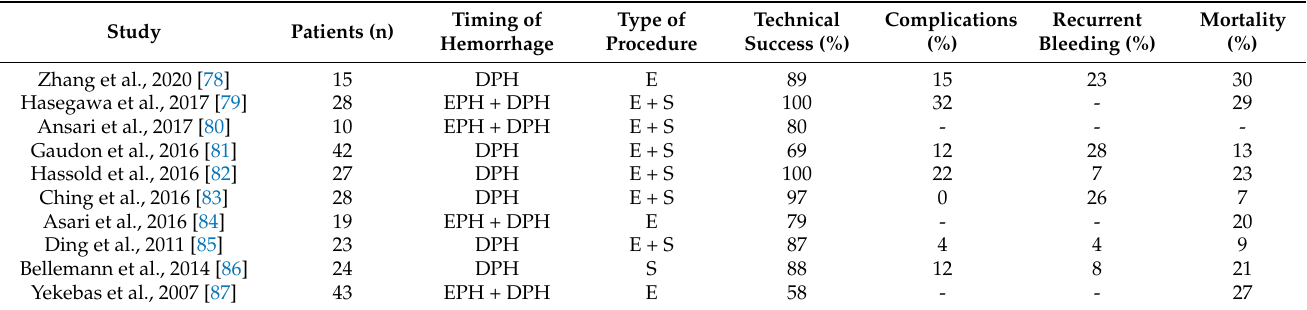
Table 1. Outcome of endovascular treatments of bleeding after pancreatic surgery. DPH, delayed post-pancreatectomy hemorrhage; EPH, early post-pancreatectomy hemorrhage; E, embolization; S, stenting.